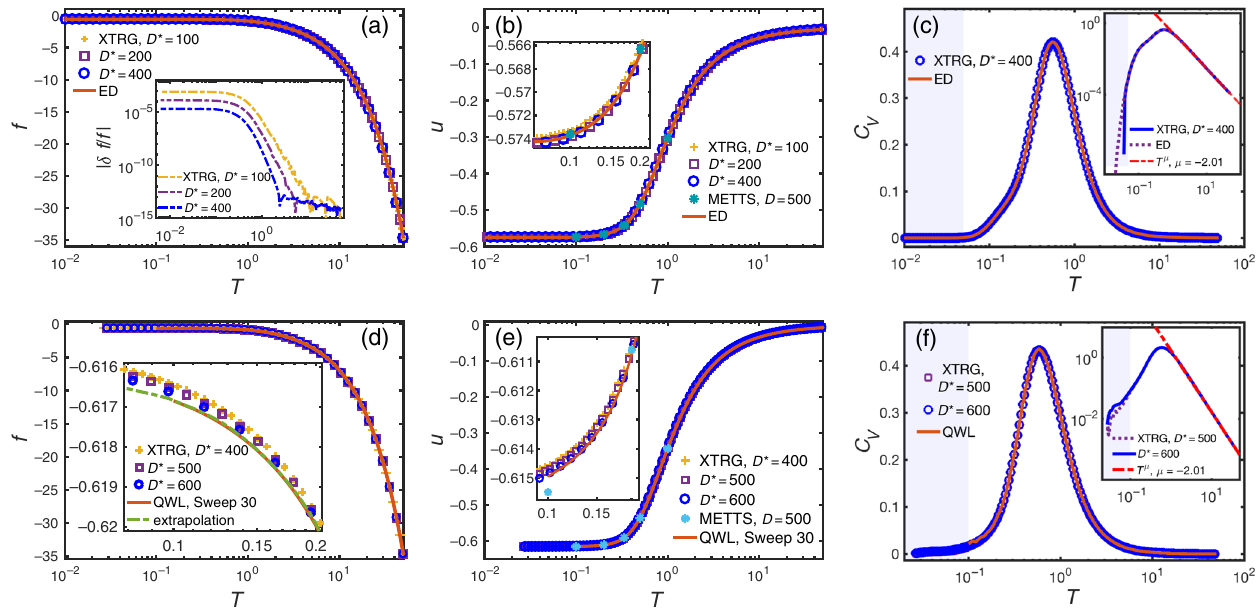
FIG. 7. Free energy f , internal energy u , and specific heat c V of the isotropic Heisenberg square lattice on an L ¼ 4 , W ¼ 4 [upper panels (a) – (c)] and L ¼ 16 , W ¼ 5 [lower panels (d) – (f)] square lattice. The XTRG results are in very good agreement with those of ED for a 4 × 4 lattice and quantum Wang-Landau (QWL) (expansion order 1200, sweep number 30, down to T=J ¼ 0 . 1 ) for the 16 × 5 lattice. With D (cid:3) the number of retained bond multiplets in the SU(2) MPO and D the corresponding number of individual U(1) states, data is shown for D (cid:3) ( D ) equal to D (cid:3) ¼ 400 (1462), D (cid:3) ¼ 500 (1832), and D (cid:3) ¼ 600 (2400), resulting in a maximal ratio D=D (cid:3) ≃ 4 . The maximal truncation errors, i.e., at largest β , are δρ ∼ 1 . 4 × 10 − 5 for a 4 × 4 lattice at D (cid:3) ¼ 400 and δρ ∼ 1 . 9 × 10 − 4 for a 16 × 5 lattice at D (cid:3) ¼ 600 . These truncation errors directly scale with the relative error in the partition function and, thus, the free energy. Extrapolating 1 =D (cid:3) → 0 by a quadratic polynomial based on D (cid:3) ∼ 300 – 600 data results in perfect agreement (green dashed line) with QWL data in (d). The low-temperature regions in (c),(f) are shaded where we have a limited accuracy of c V . The insets in (c),(f) fit the high- T specific heat with T μ , resulting in μ ¼ − 2 . 01 in both cases (based on the last eight points, i.e., T > 30